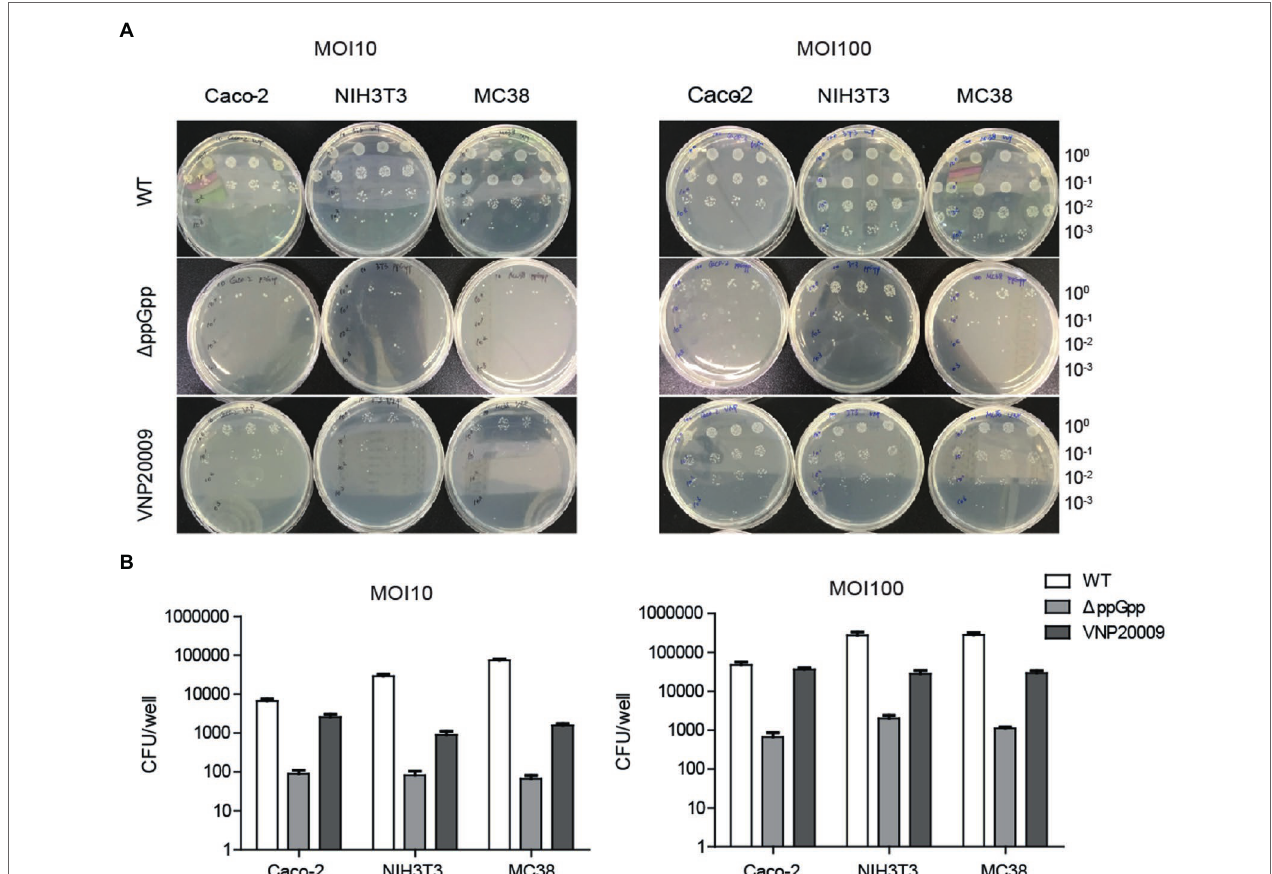
FIGURE 2 | Δ ppGpp showed weaker cell invasion than VNP20009 in vitro . (A) Caco-2, NIH3T3, and MC38 were co-cultured with Δ ppGpp, VNP20009, and WT at different infection coefficients (MOI 10 and MOI 100) for 1 h, followed by 150 μ g/ml gentamycin for an additional 30 min. The cells were then lysed to quantify the number of bacteria in the cells. (B) The numbers of bacteria invading cells under different infection conditions were recorded and